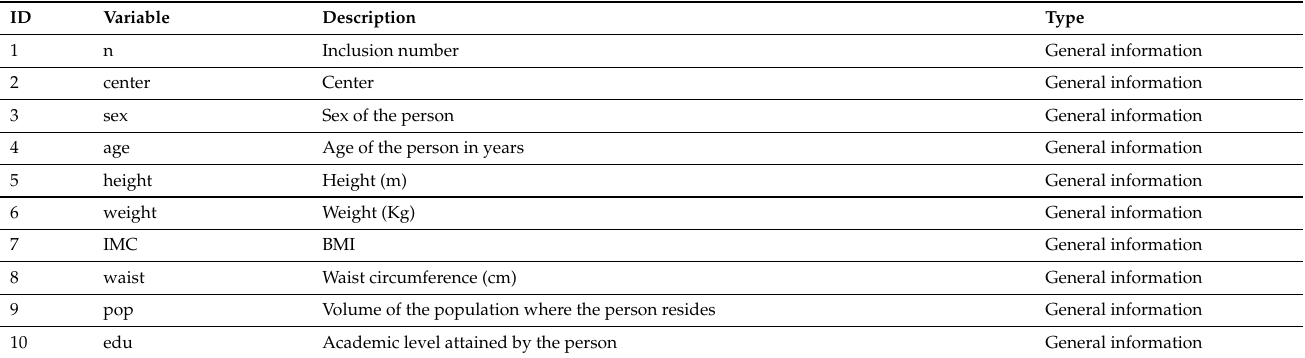
Table A2. Representation of all variables in the original data